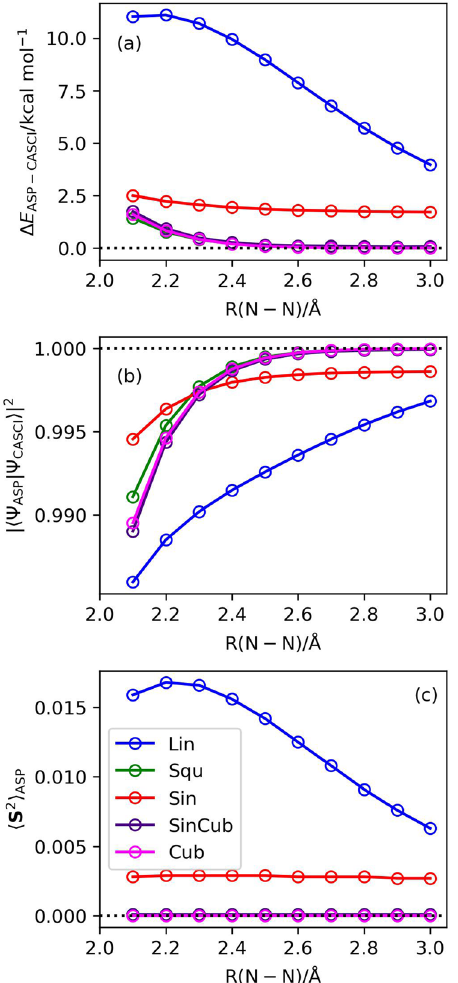
Fig. 7 Numerical simulation results of the scheduling function dependence on ASP with the | Ψ BS 〉 as the starting wave function and T = 50 in N 2 molecule. a The energy deviations from the CASCI values. b The square overlaps with the CASCI wave functions. c The 〈 S 2 〉